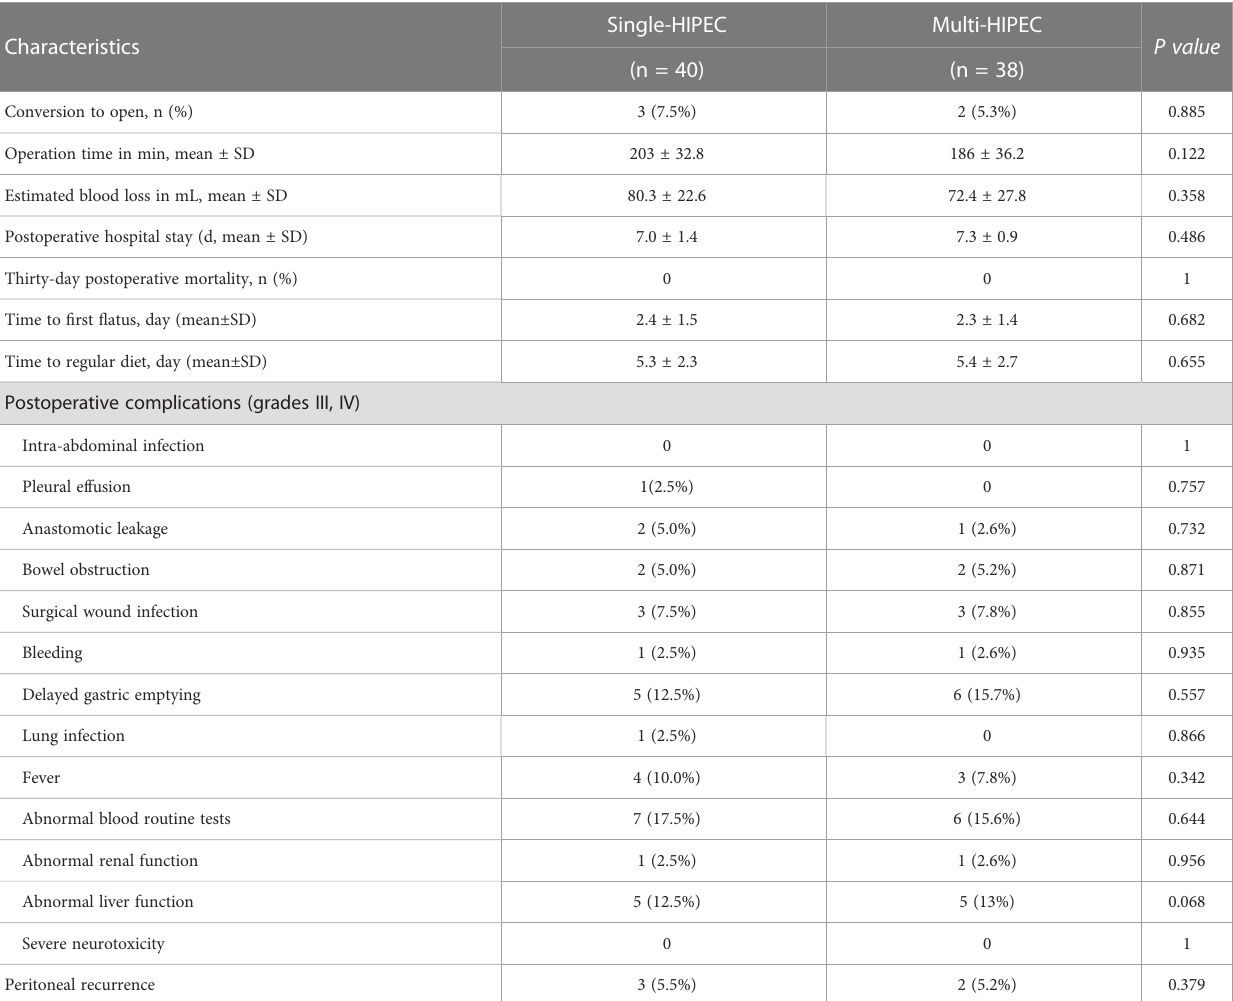
TABLE 2 Perioperative data of the